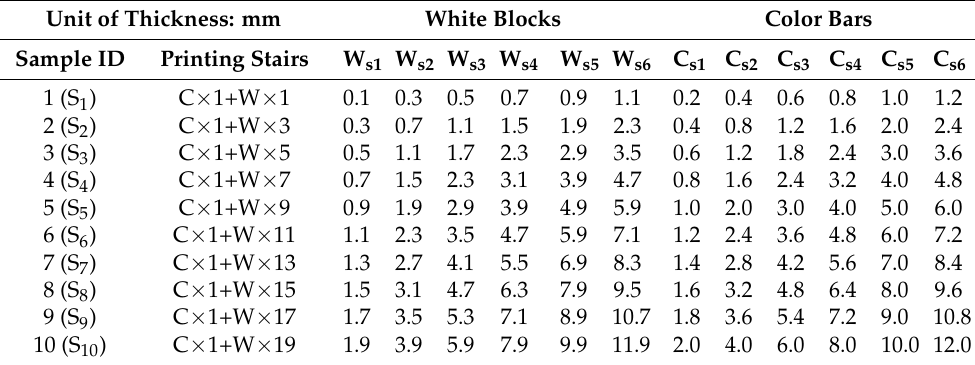
Table 1. Printing layers and thickness of each paper-based 3D model.